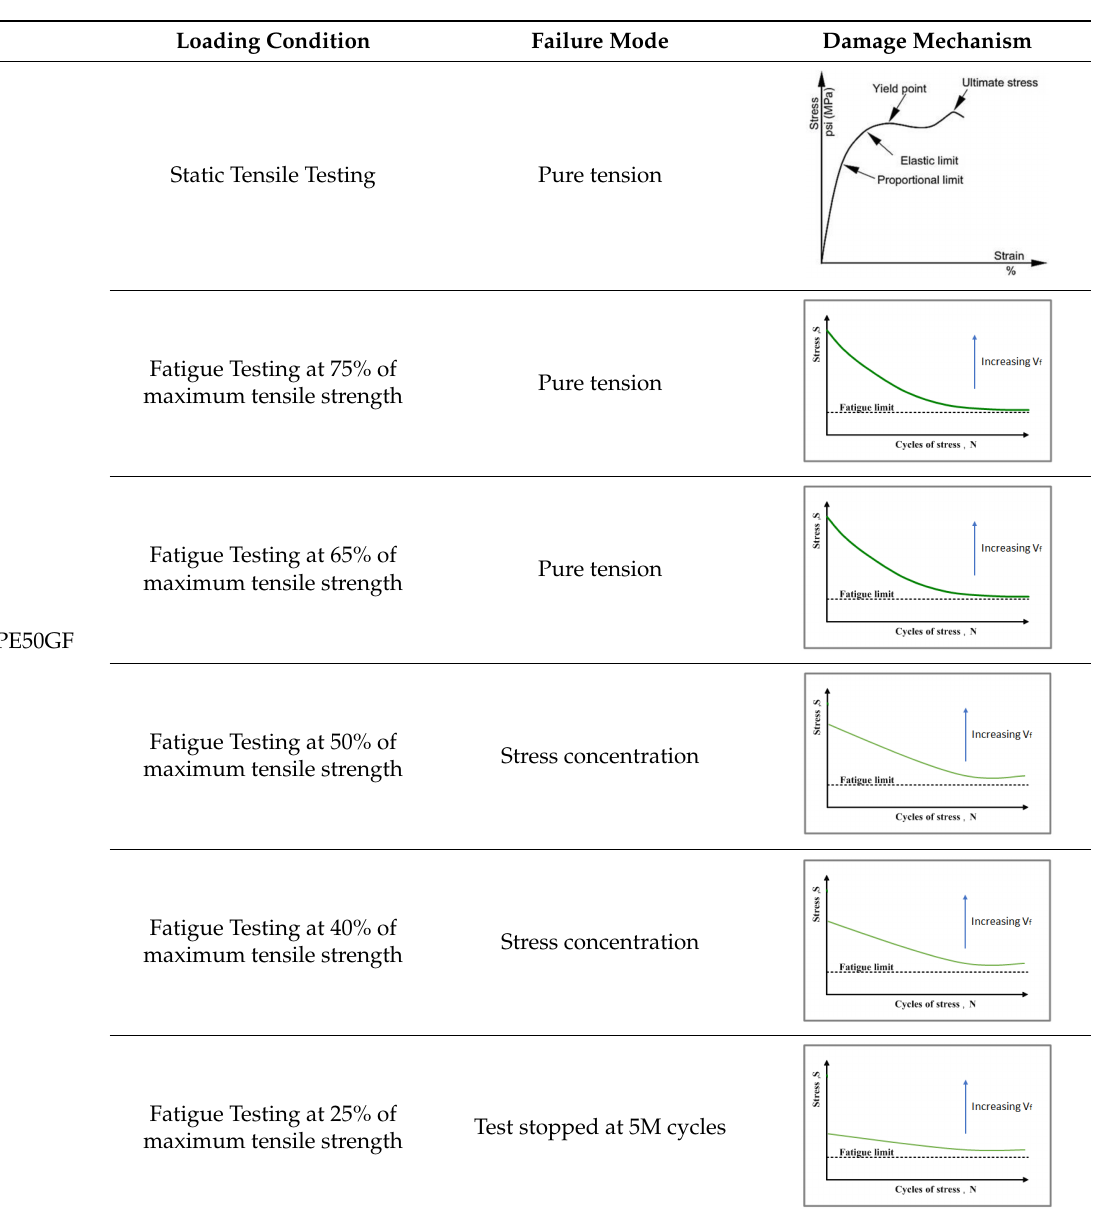
Table 5. Schematic representation of the mechanical behaviour and attributed damage mechanisms in glass fibre-reinforced polyester composites based on varied fibre volume fractions and applied stress